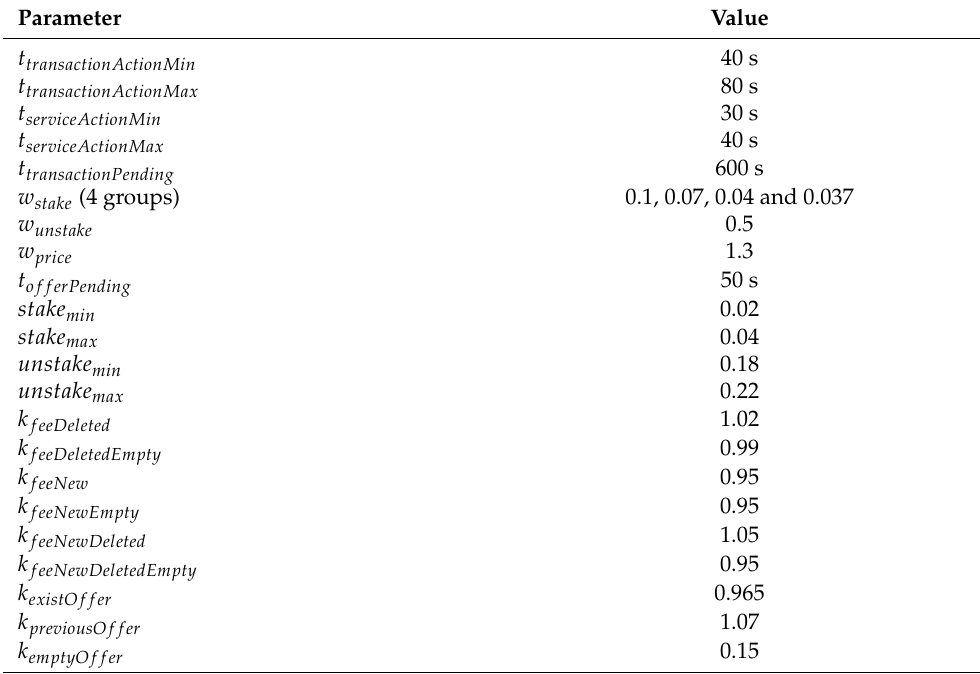
Table 4. Selected agent model setting